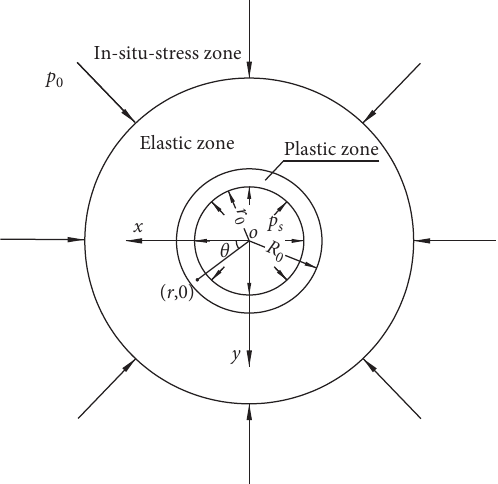
Figure 2: Elastic-plastic zone of circular